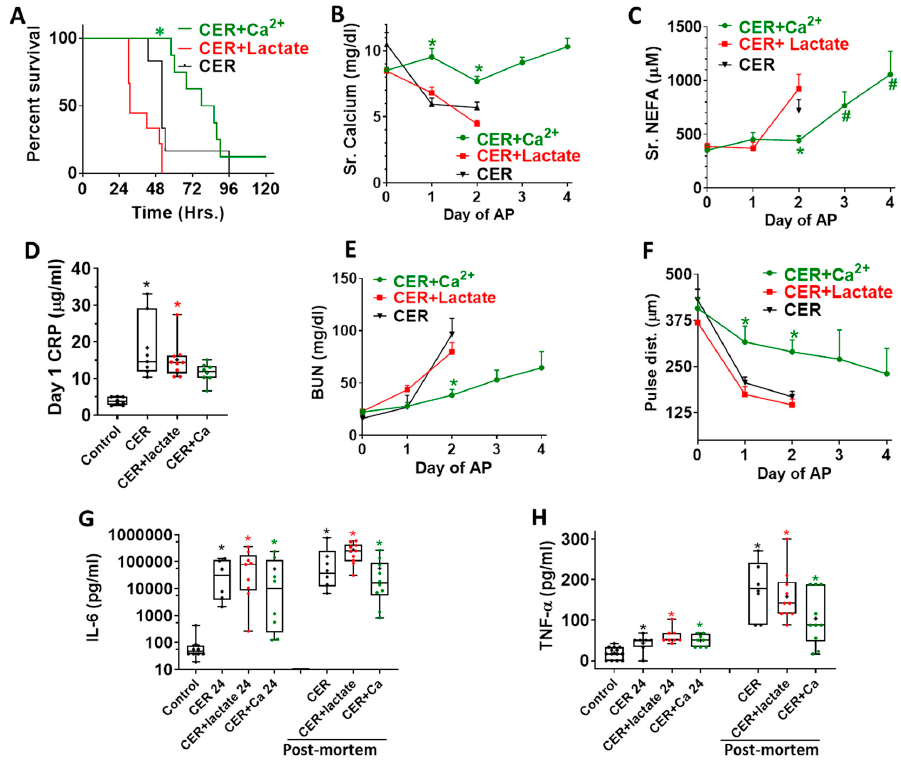
Figure 5. Effect of no treatment (black), calcium (green), or lactate treatment (red) on parameters of systemic injury and inflammation: ( A ) Kaplan–Meyer survival curve of the various groups with pancreatitis * indicates a p < 0.05 in the CER + calcium (CER + Ca 2 + )-treated group vs. other groups. ( B ) serum calcium and ( C ) Serum NEFA, as measured at each day of pancreatitis. * indicates a p < 0.05 in the CER + calcium treated groups vs. other groups on ANOVA. # indicates a significant di ff erence from baseline (day 0). ( D ) Blood C-reactive protein (CRP) after 24 h of pancreatitis. * indicates a significant increase in the group on ANOVA vs. control mice without pancreatitis. ( E ) Blood urea nitrogen (BUN) and ( F ) Carotid artery pulse distention (pulse dist.), as measured on each day of pancreatitis. * indicates a p < 0.05 in the cer + calcium-treated groups vs. other groups on ANOVA. Interleukin 6 (IL-6) ( G ) and tumor necrosis factor (TNF- α ) ( H ) blood levels, one day after pancreatitis initiation (each title followed by 24), and on the post-mortem blood samples. * indicates a significant increase on ANOVA for that time point vs.